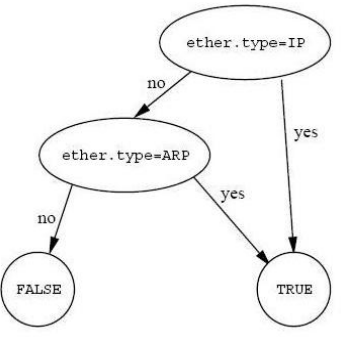
Fig. 5. BPF Filter